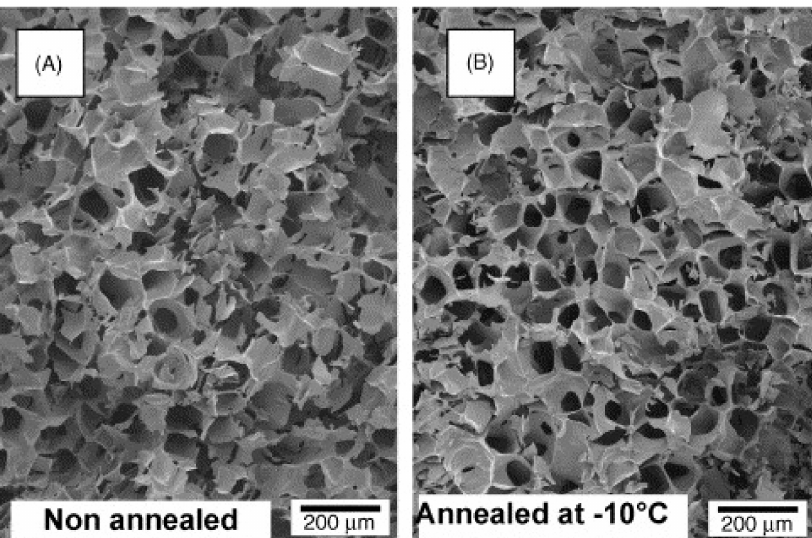
Figure 4. Structure of freeze-dried PVP without annealing ( A ) and with annealing at − 10 ◦ C ( B ). Note that the two plugs had a leafy amorphous appearance consisting of an irregular array of large pores which had been previously occupied by ice (magnification 60 × ). Adapted with permission from ref. [104]. 2021, Springer Nature.